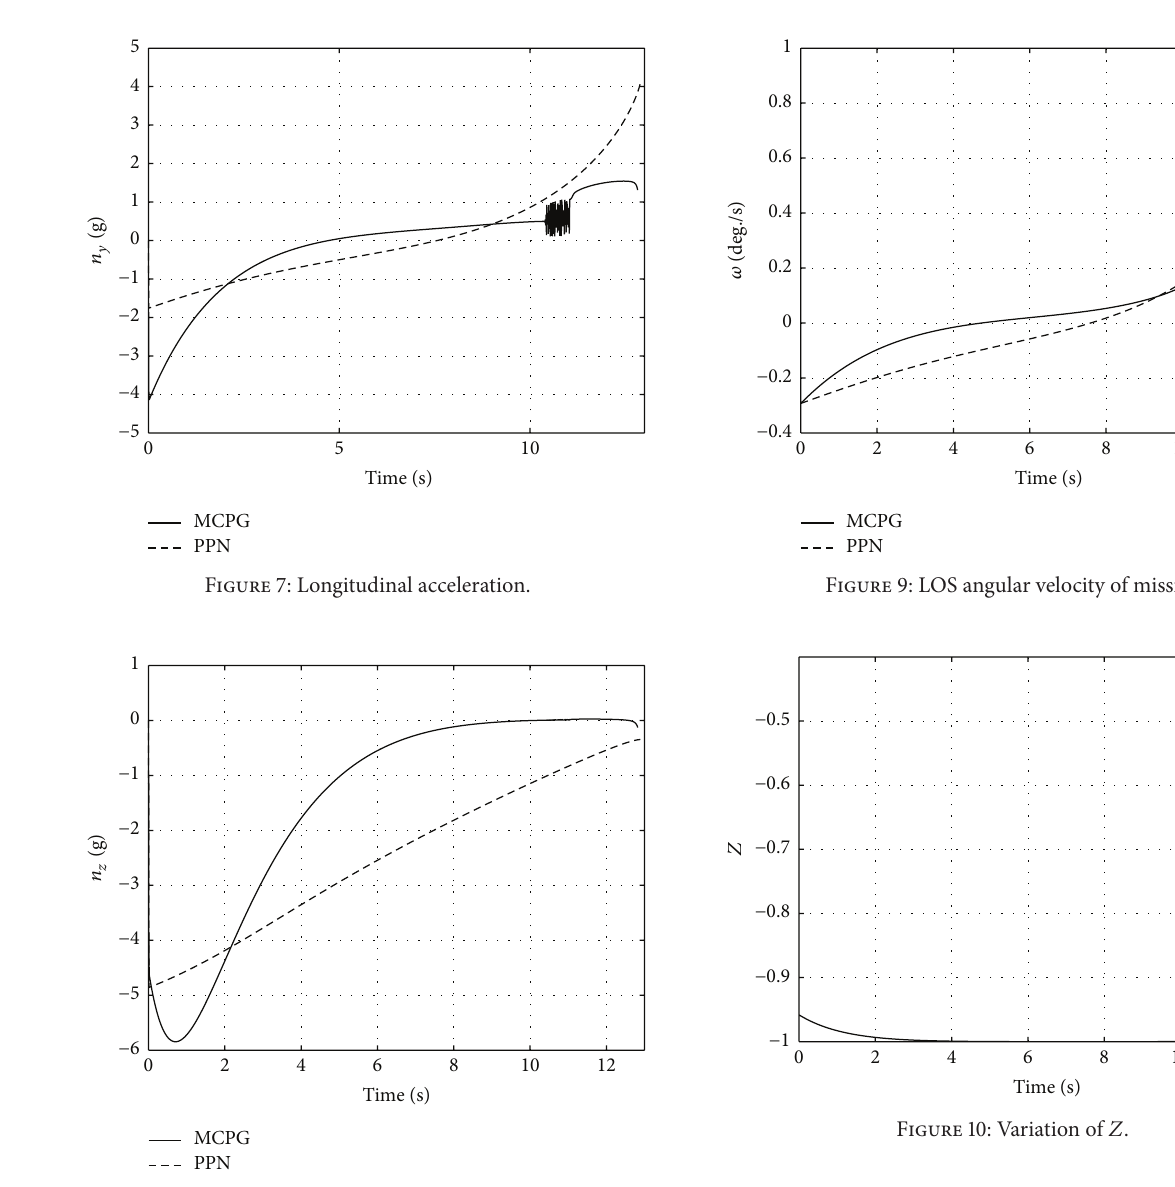
Figure 8: Lateral acceleration.